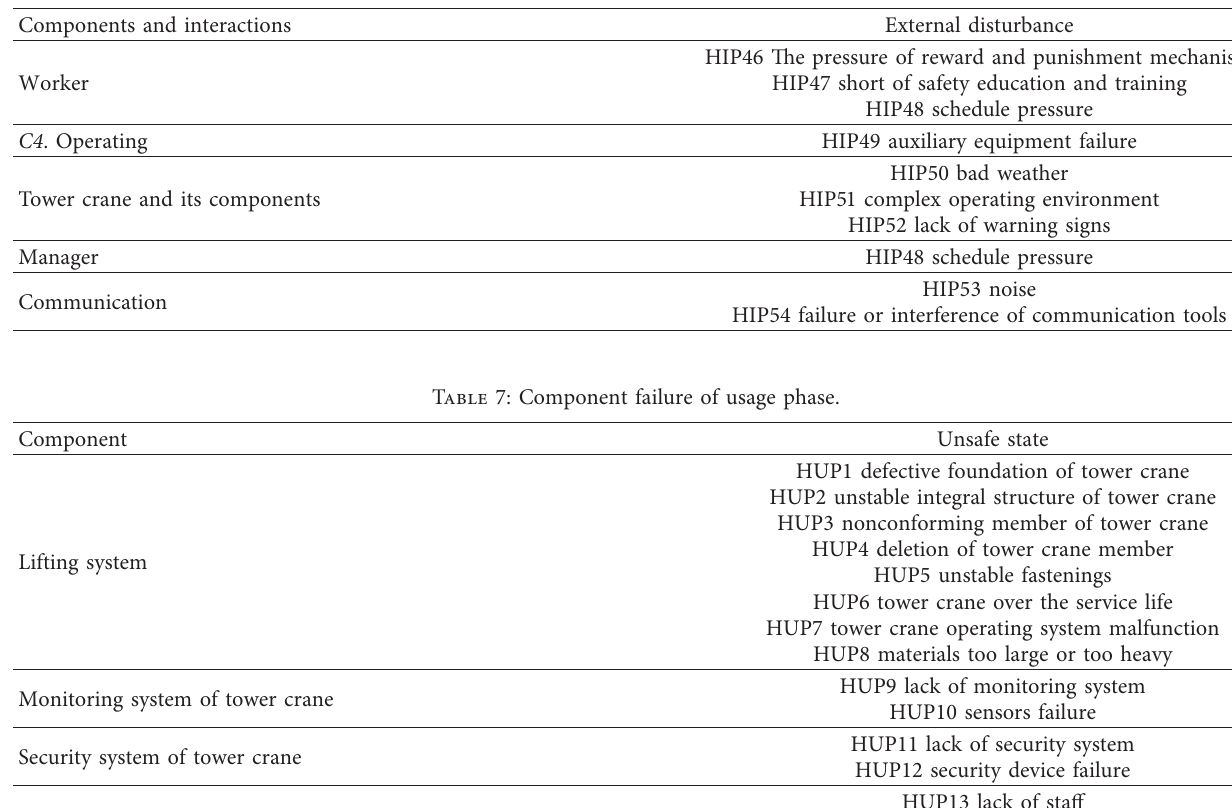
Table 6: External disturbance of installation.